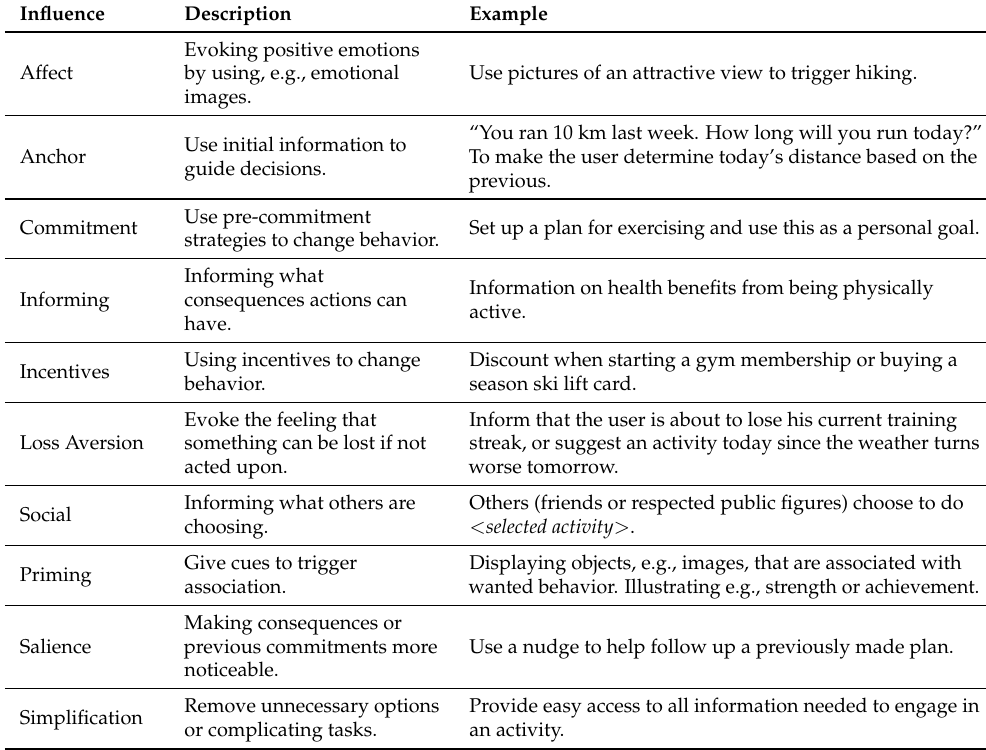
Table 3. Types of